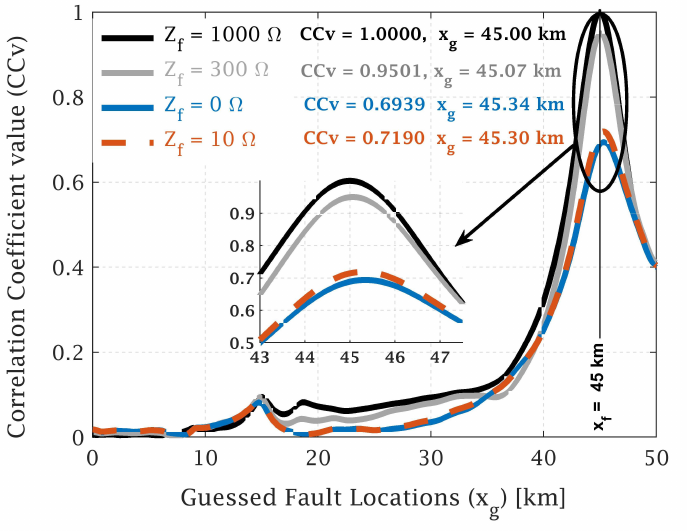
Figure 9. CCvs as a function of the GFL ( x g ): considering different values of Z f in the fault occurrence stage, while in the fault estimation stage, Z f = 1000 Ω ; the test fault location is 45